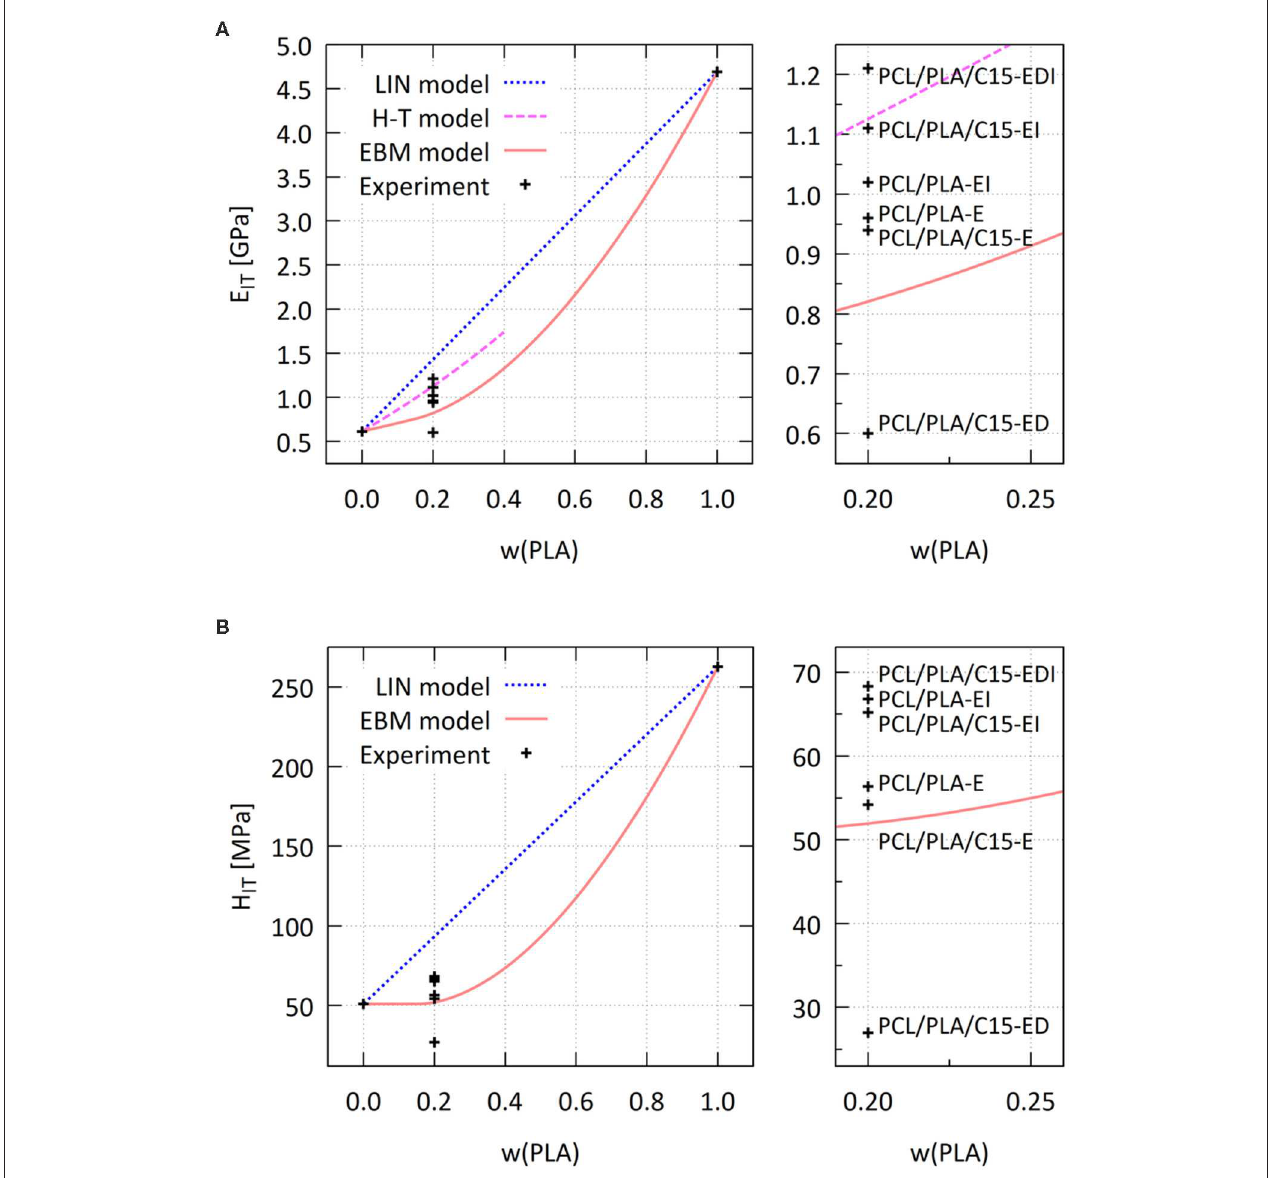
FIGURE 8 | Comparison of experimental values of (A) indentation modulus and (B) indentation hardness with theoretical predictions based on linear model (LIN; dotted line), Halpin-Tsai model for short oriented fibers with aspect ratio = 4 (HT; dashed line), and equivalent box model calculated with default parameters (EBM; full line); the smaller graphs on the right show enlarged areas with experimental points from all PCL/PLA/C15 systems (see Table 1 for explanation of sample